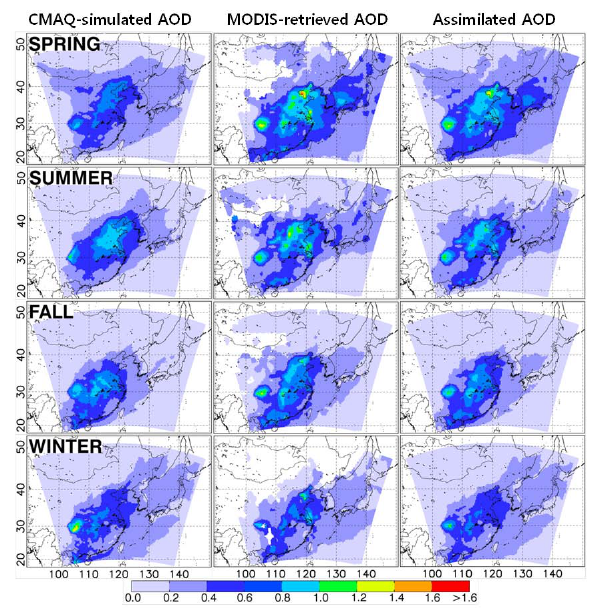
Fig. 9. Spatial distributions of the CMAQ-simulated, MODIS- retrieved and assimilated AODs over East Asia for all four seasons,